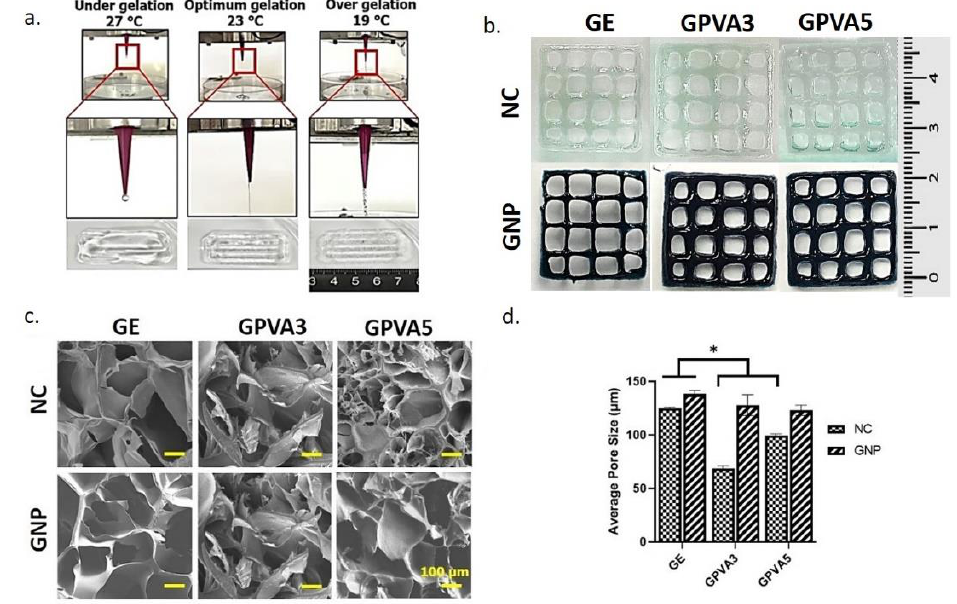
Figure 8. Assessment of the potential bioinks using the 3D-bioprinting fabrication technique: ( a ) printability assessment, ( b ) gross appearance of the 3D-printed hydrogels, ( c ) SEM images of the 3D-printed hydrogels, and ( d ) average pore sizes of the 3D-printed hydrogels. Whereas, * indicates the significant difference.